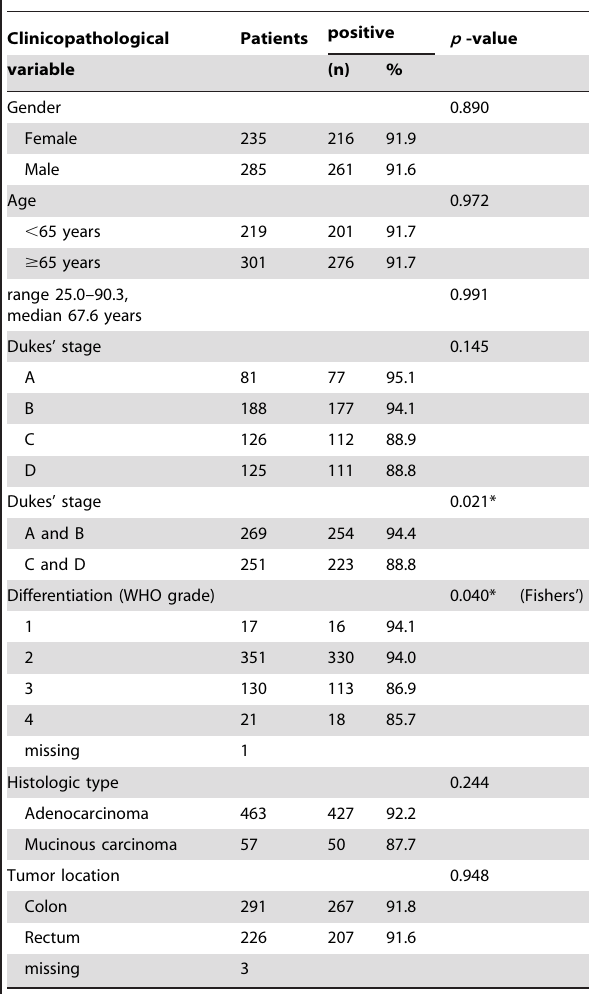
Table 1. Patient clinicopathological characteristics and their correlation with EGFR immunoreactivity in 520 colorectal cancer patients assessed with chi-square test ( a Mann-Whitney test).